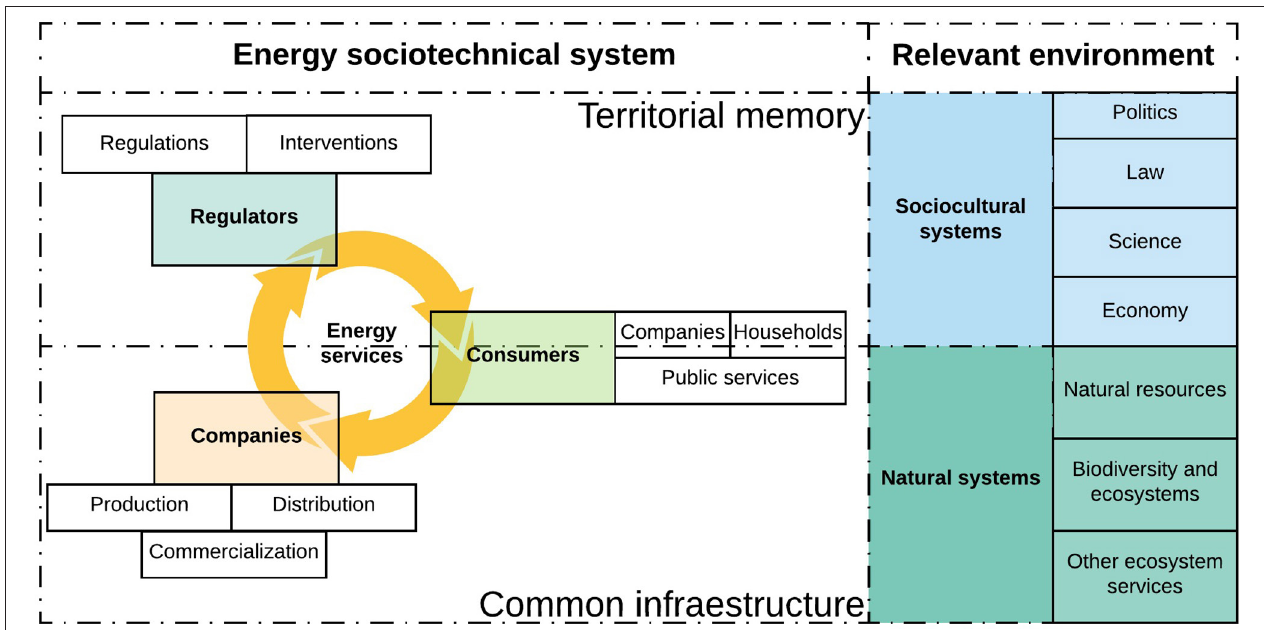
FIGURE 1 | Schematic representation of energy sociotechnical system. Source: adapted from Red de Pobreza Energética